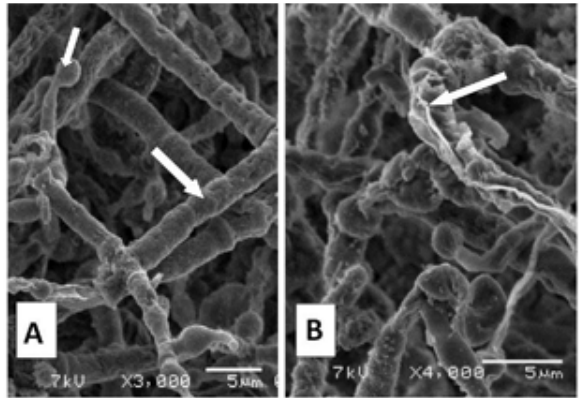
Figure 1. SEM micrographs showing effects of ethanol extract from of Calotropis procera on the morphology of Alternaria solani hyphae. (a) Hyphae of control treatment (untreated) showing normal hypha (long arrow). Note immature conidium (short arrow). Bar = 10 μm. (b) Hy - phae after the treatment with plant extract (20%). Note col- lapsed hypha (arrow). Bar = 5.0 μm.